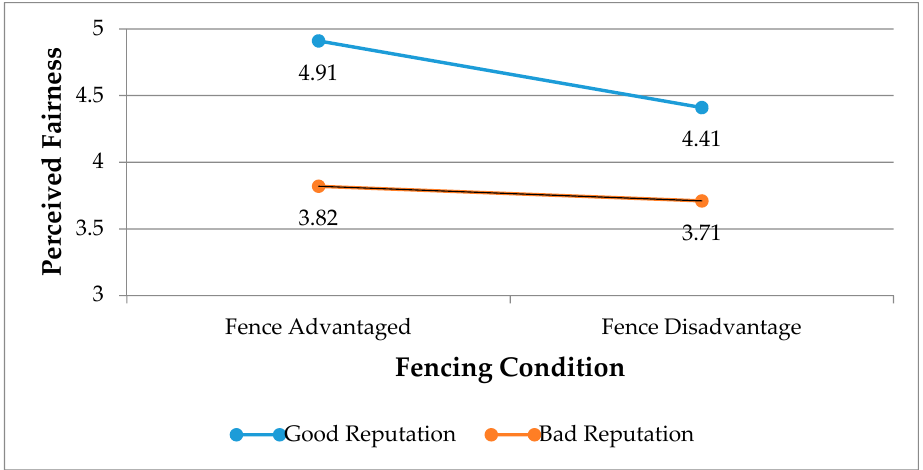
Figure 2. Interaction effects between reputation and fencing condition on perceived fairness.